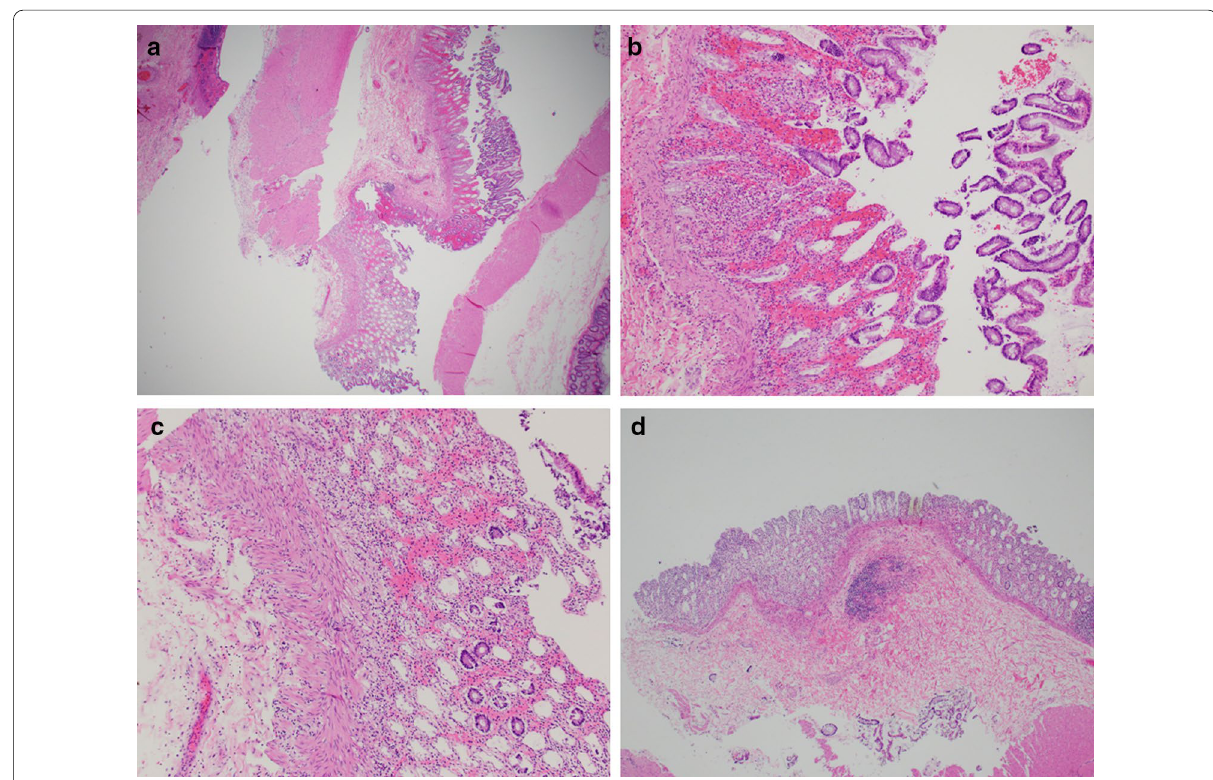
Fig. 3 Histopathological analysis of the excised sigmoid colon showing ischemic changes. a – c Sigmoid colonic section showing mucosal sloughing, mucosal hemorrhages, and fibrin deposition which are all indications of ischemia; H&E stain 10 4 of lower portion of image a ( c ). d Similar ischemic changes seen in a section from a different site of the excised tissue; H&E stain 10 ×